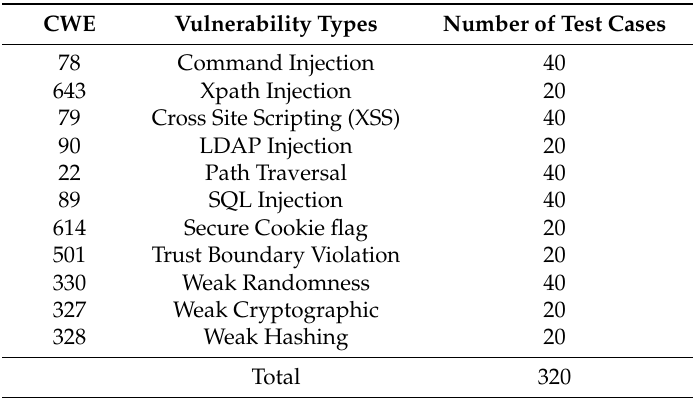
Table 1. OWASP Benchmark Project Test Cases.